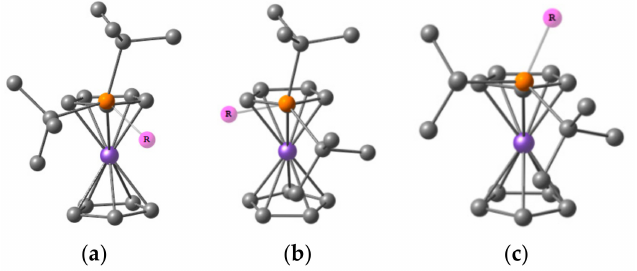
Figure 5. Considered conformations ( a – c ) of cation part of IL models, R = Me ( m1 ), Et ( m2 ), Pr ( m3